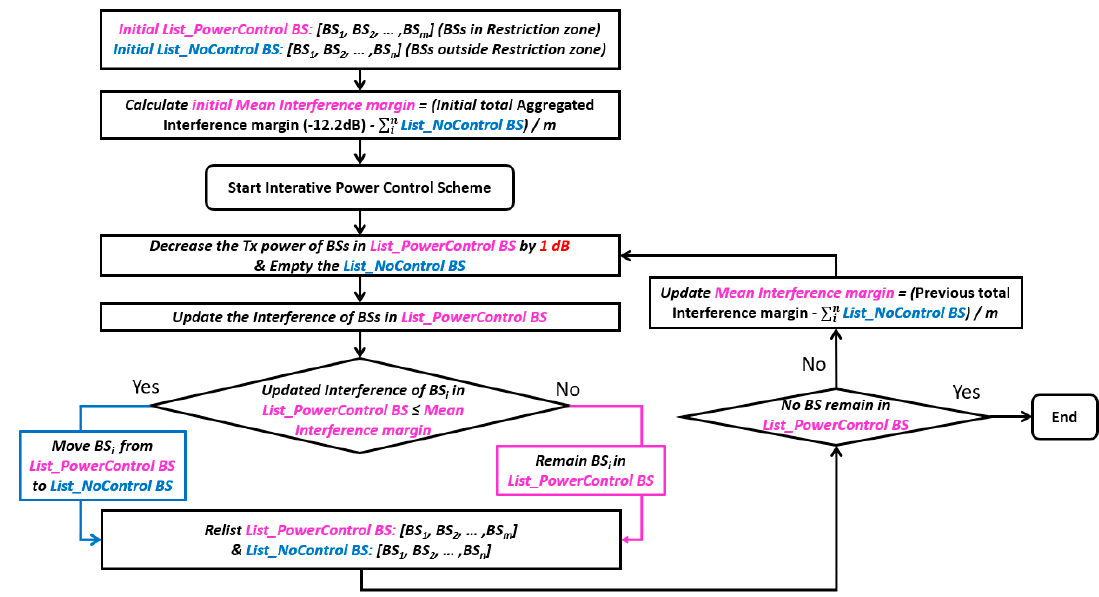
Figure 9. Flowchart for distance protection method: Interactive BS Tx power control scheme.